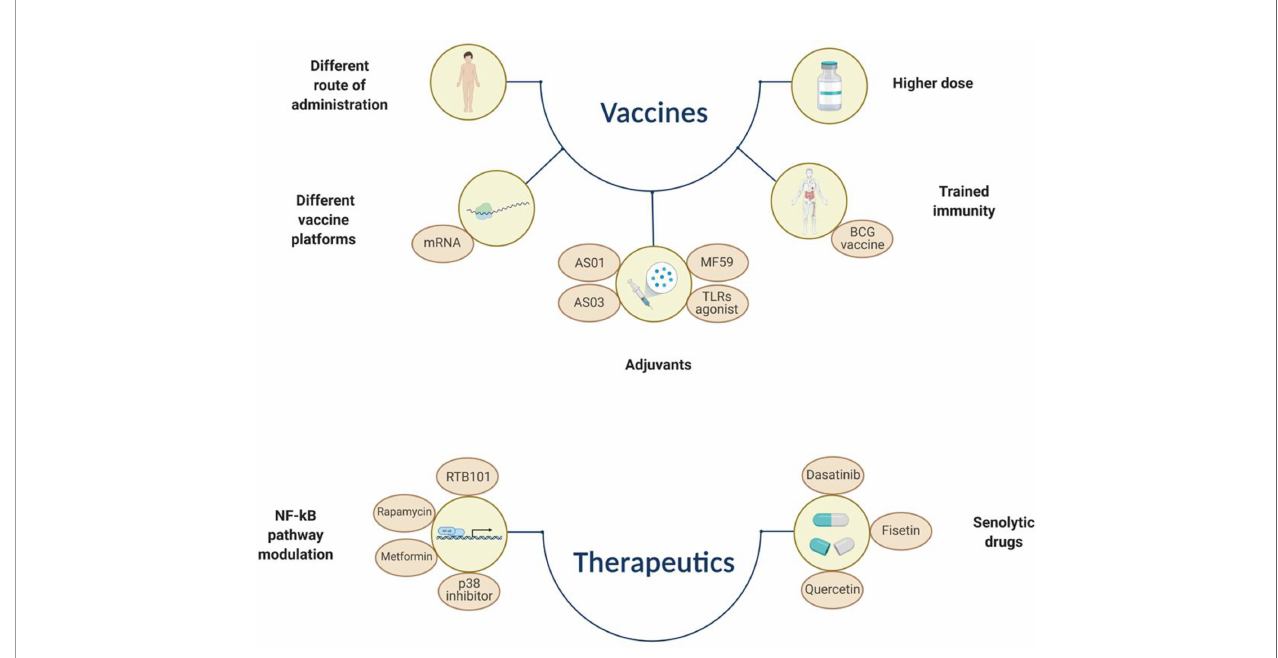
FIGURE 2 | Simpli fi ed representation of different approaches that aim to overcome immunosenescence by increasing vaccine immunogenicity/ef fi cacy or by using therapeutics that can dampen the SASP effect or induce selective apoptosis of immunosenescent cells. BCG, Bacillus Calmette – Gue ́ rin; TLR, toll like receptor. The fi gure was created with